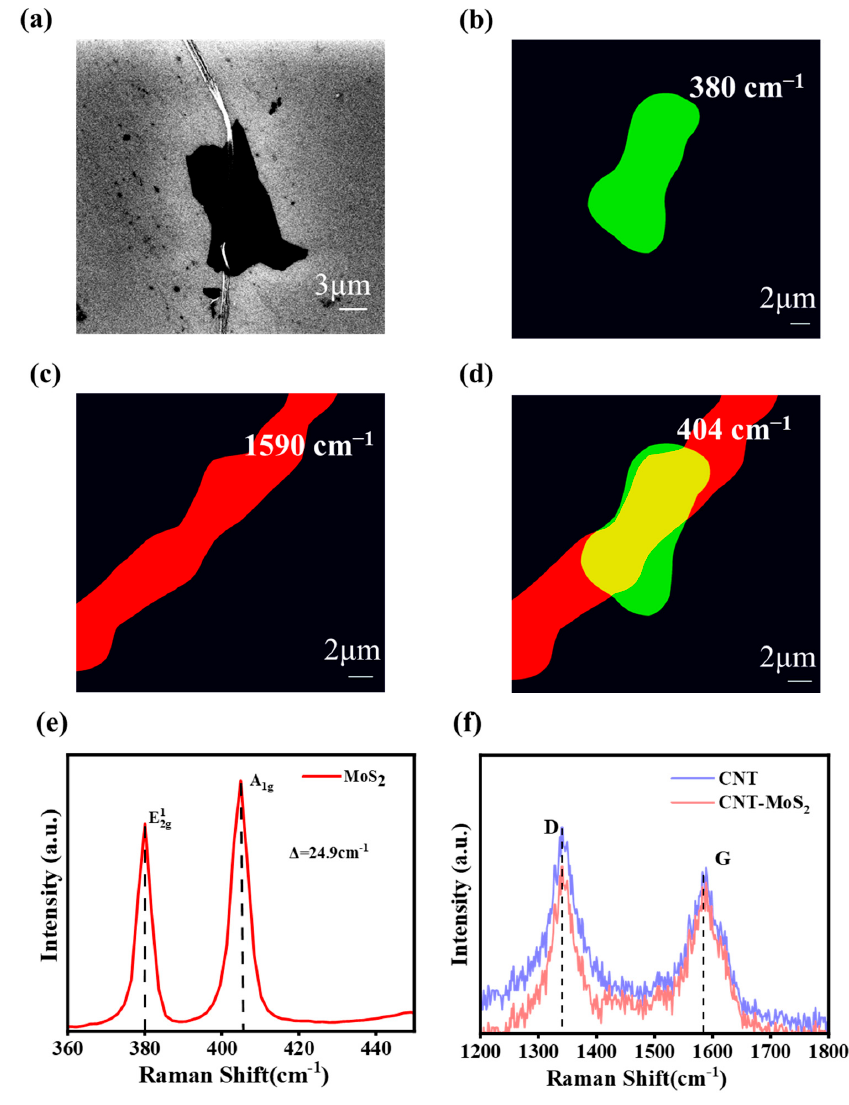
Figure 4. ( a ) Scanning electron microscopy images of selected individual MWCNT-MoS 2 heterostructure; ( b–d ) Raman mapping acquired from the MoS 2 region and the planar stacked MWCNT-MoS 2 region, respectively; ( e ) Raman spectra of MoS 2 ; ( f ) Raman spectra of CNT-MoS 2 and bare CNT.